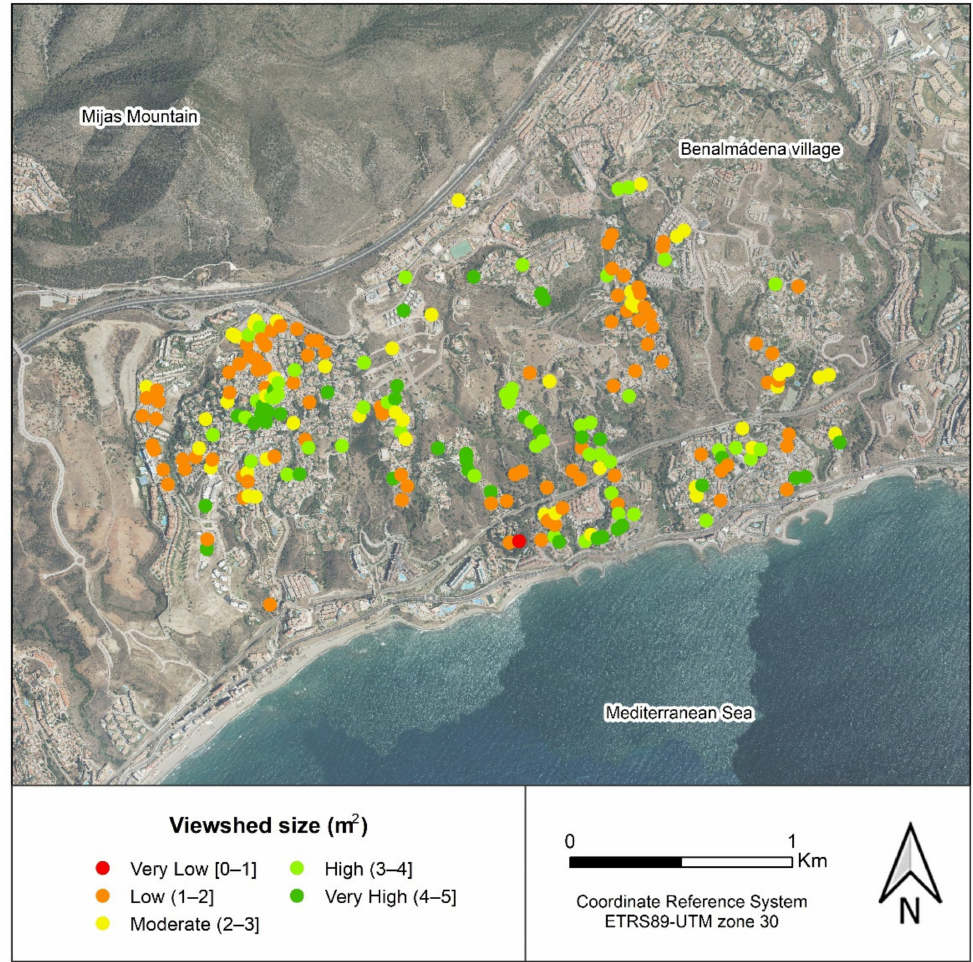
Figure 8. Buildings analyzed according to the size of the visual basin (own